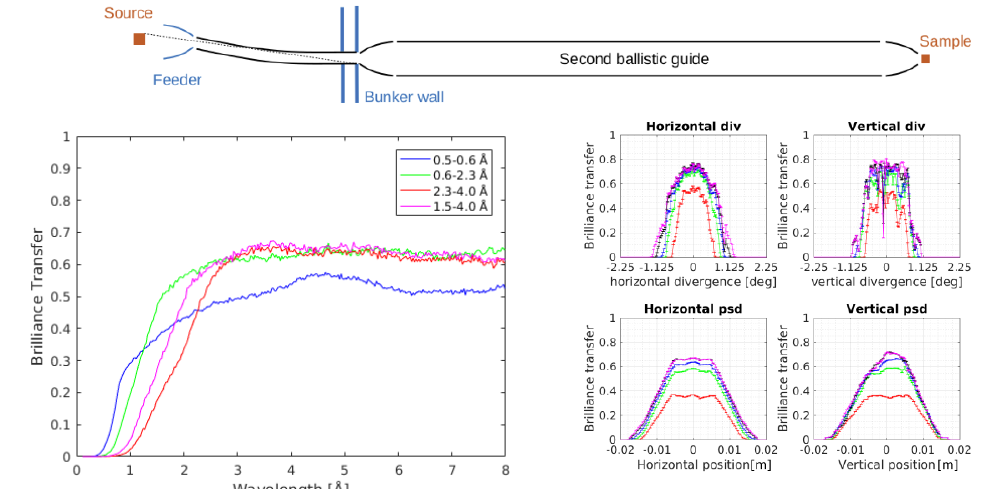
Figure 6. Curved guide. Performance of coating-optimized curved guides. Top: Schematic drawing of the curved guide: the double-pinhole guide, where the direct line-of-sight from the moderator is broken by a 19 m long curved section between the two pinholes. The figures is not to scale. The bottom panels show the performance of coating-optimized curved guides. Left: Simulated values of BT ( λ ) as a function of neutron wavelength optimized for coating value and geometry for the wavelength bands WB1 (blue), WB2 (green), WB3a (red), and WB3b (purple), using a pinhole size of height × width = 5 × 3 cm 2 . Right: Integrated BT of the curved guide, optimized for WB3b, 1.5–4.0 Å. The panels show the BT as a function of horizontal/vertical position and divergence for different wavelengths marked by colors. (red: 1.5 Å, green: 2.1 Å, blue: 2.8 Å, black: 3.4 Å, purple: 4.0